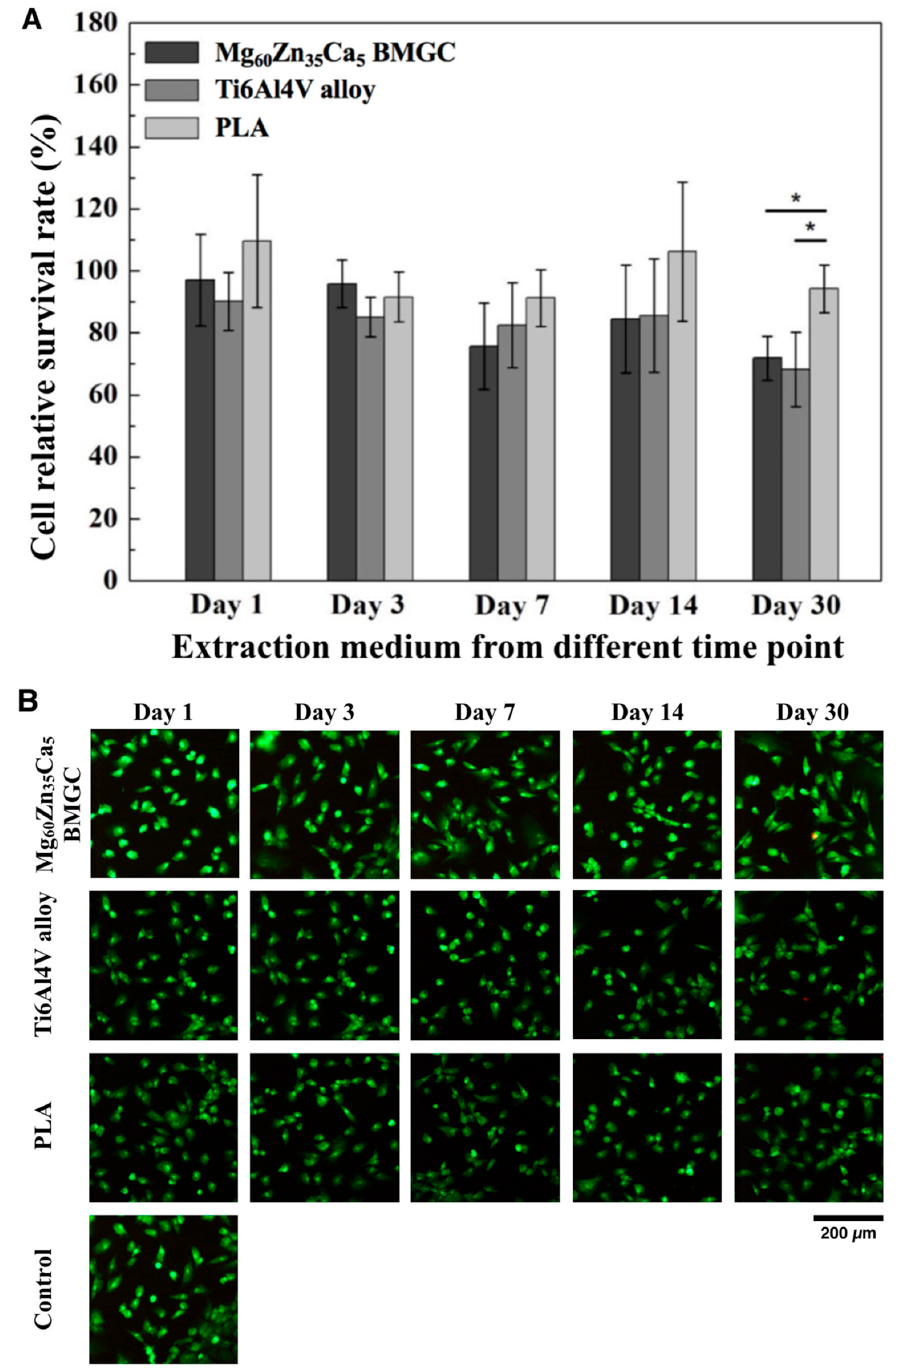
Figure 1. Cell viability of primary rabbit osteoblasts cultured in either Mg 60 Zn 35 Ca 5 , Ti6Al4V alloy or PLA-derived extraction medium for different periods. ( A ) MTT assay. ( B ) Live/dead assay. (* p < 0.05).